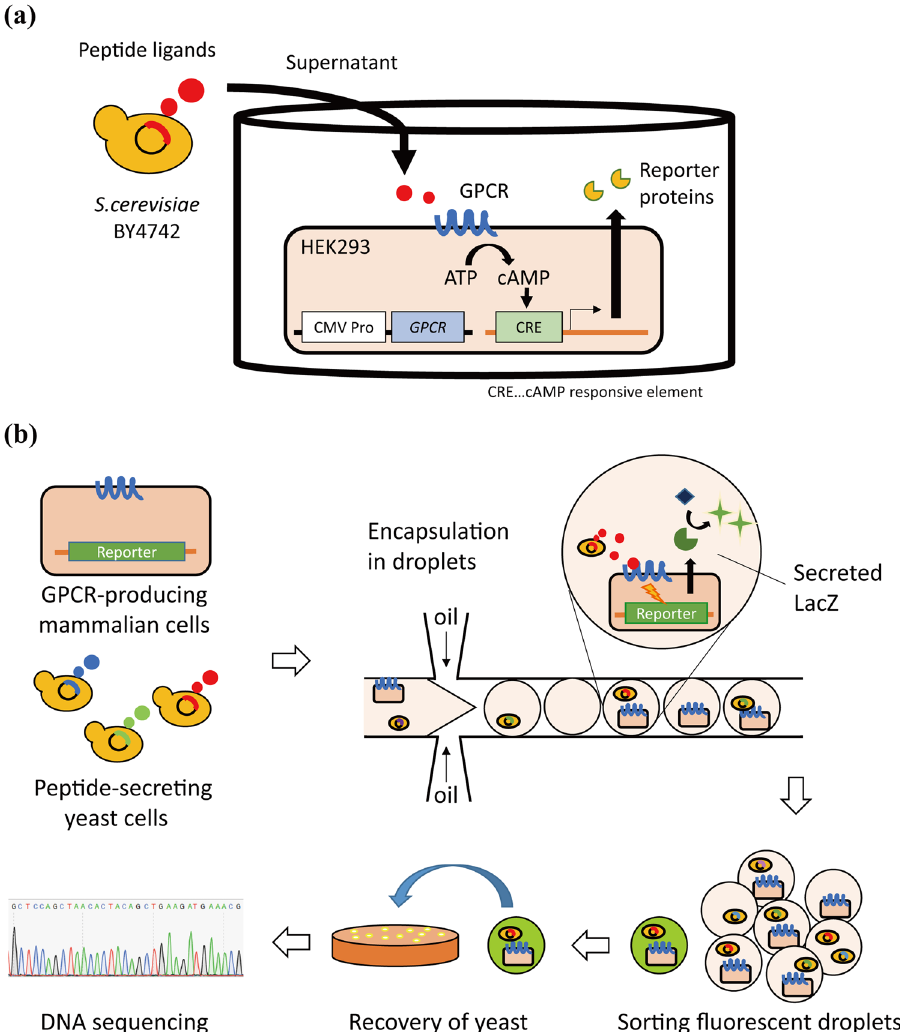
Figure 1. Schematic of the high-throughput functional cell-based assay using droplet microfluidics. ( a ) Functional cell-based assay using GPCR-producing reporter cells and ligand-secreting yeast cells. When peptide ligands secreted by yeast cells activate GPCRs produced by HEK293, a reporter gene is activated via cAMP response element (CRE). ( b ) High-throughput functional cell-based assay using droplet microfluidics. The reporter cells and the yeast cells secreting randomized peptide ligands are encapsulated in droplets and co- cultured. When a randomized peptide ligand secreted by a single yeast cell activates the reporter cell, resulting in the production of reporter proteins (LacZ), a droplet emits strong fluorescence. The fluorescent droplets are isolated, and the yeast cells producing functional peptide ligands are cultured on a plate medium. Finally, sequences of the functional peptide ligands are determined using DNA